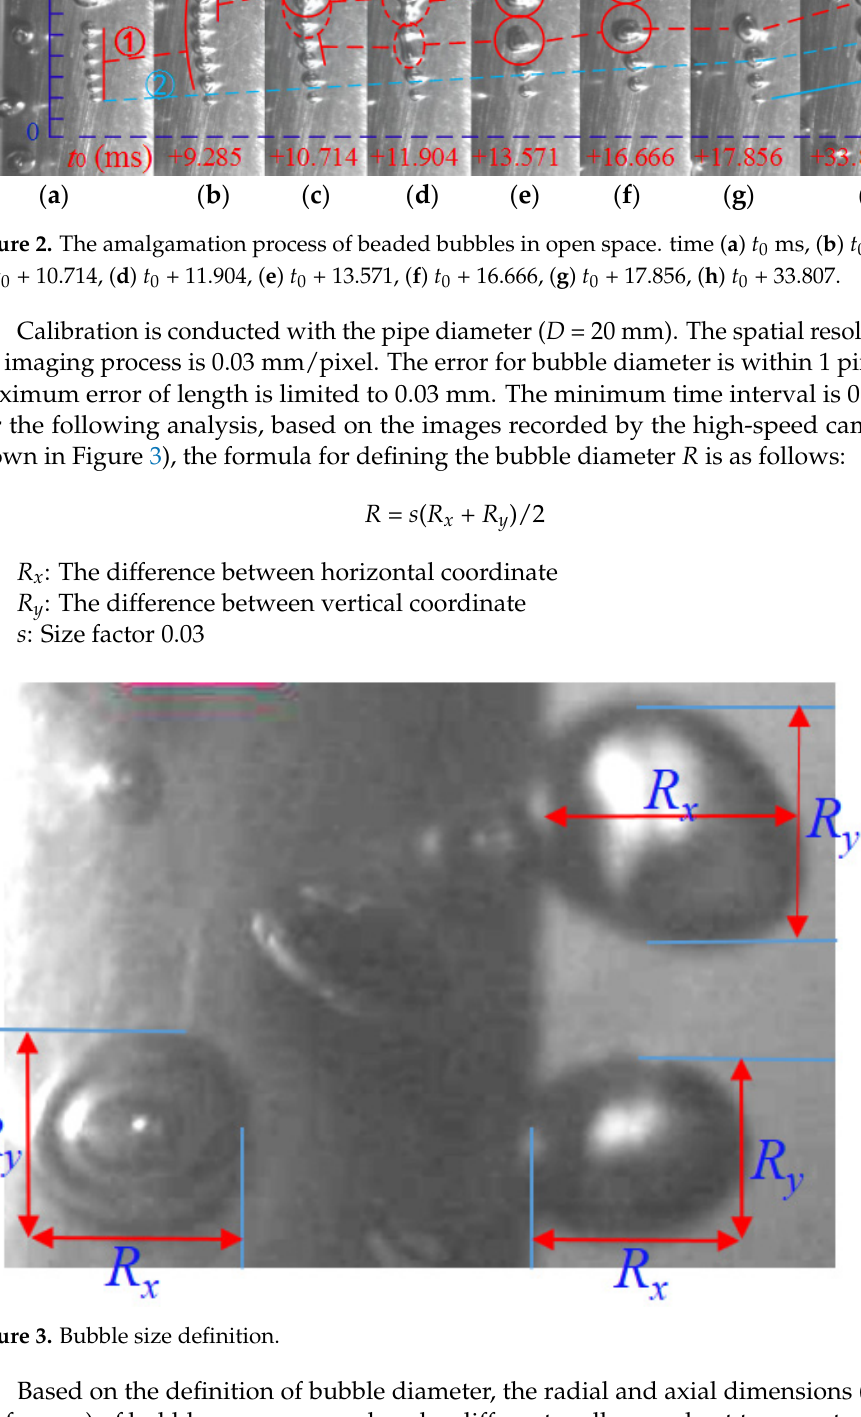
Figure 3. Bubble size